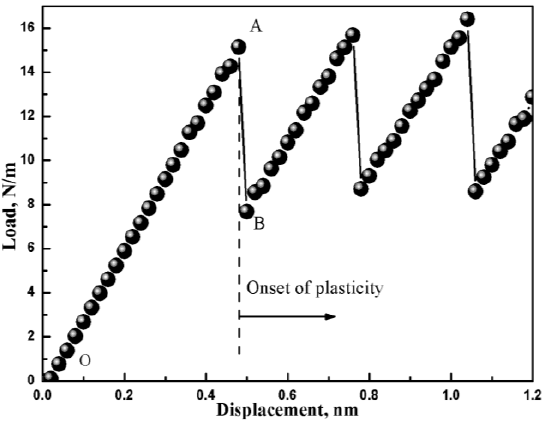
Figure 2. Load-displacement curves for nanoindentation on Al film without surface pit.